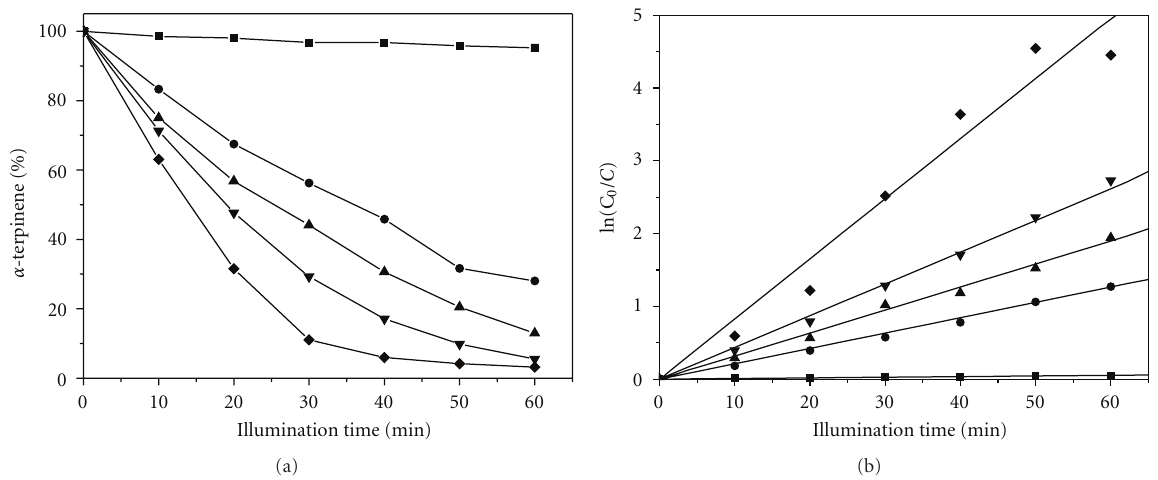
Figure 11: (a) E ff ect of catalyst amount on the photooxidation of α -terpinene (b)The pseudo-first-order photocatalysis rate constants of α -terpinene ( (cid:2) ) TiO 2 (1mg/mL) and APTMPP-MPS-TiO 2 ( • ) 0.5mg/mL ( (cid:3) ) 1mg/mL ( (cid:4) ) 1.5mg/mL ( (cid:5) )